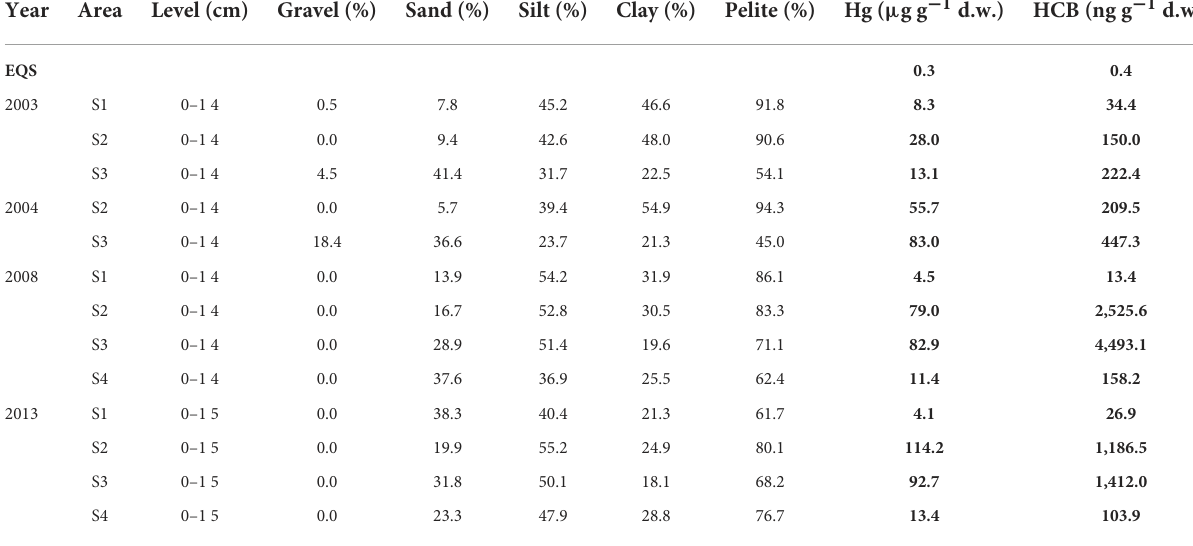
TABLE 3 Mean values of textural parameters and contaminants in superficial sediments (0–1